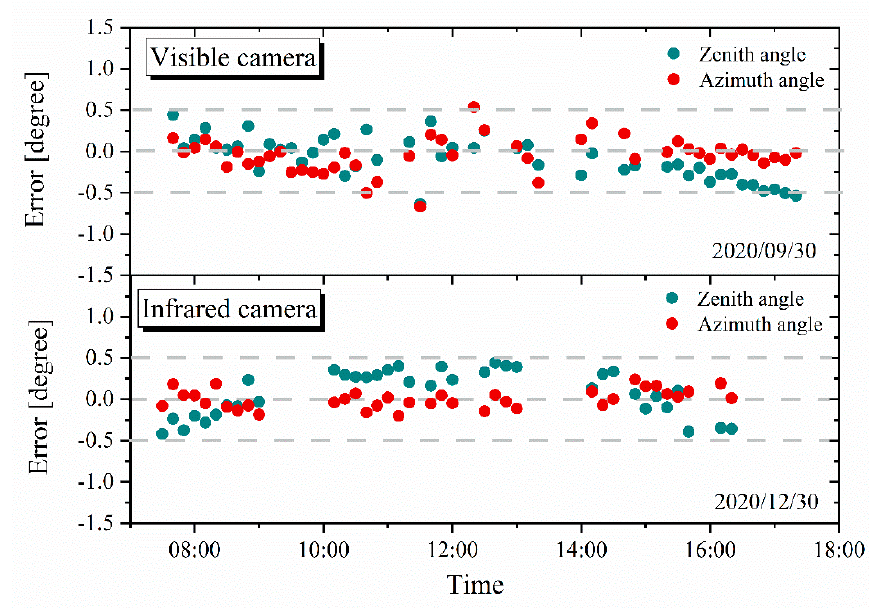
Figure 7. Back projection errors of the visible and infrared all-sky-view cameras. To analyze the back projection errors statistically, the Root Mean Square Error (RMSE), Normalized Mean Square Error (NRMSE), Mean Absolute Error (MAE), Normal- ized Mean Square Error (NMAE), and Standard Deviation (SD) are used, as follows: RMSE = (cid:3496) 1 (cid:1866) (cid:3533)